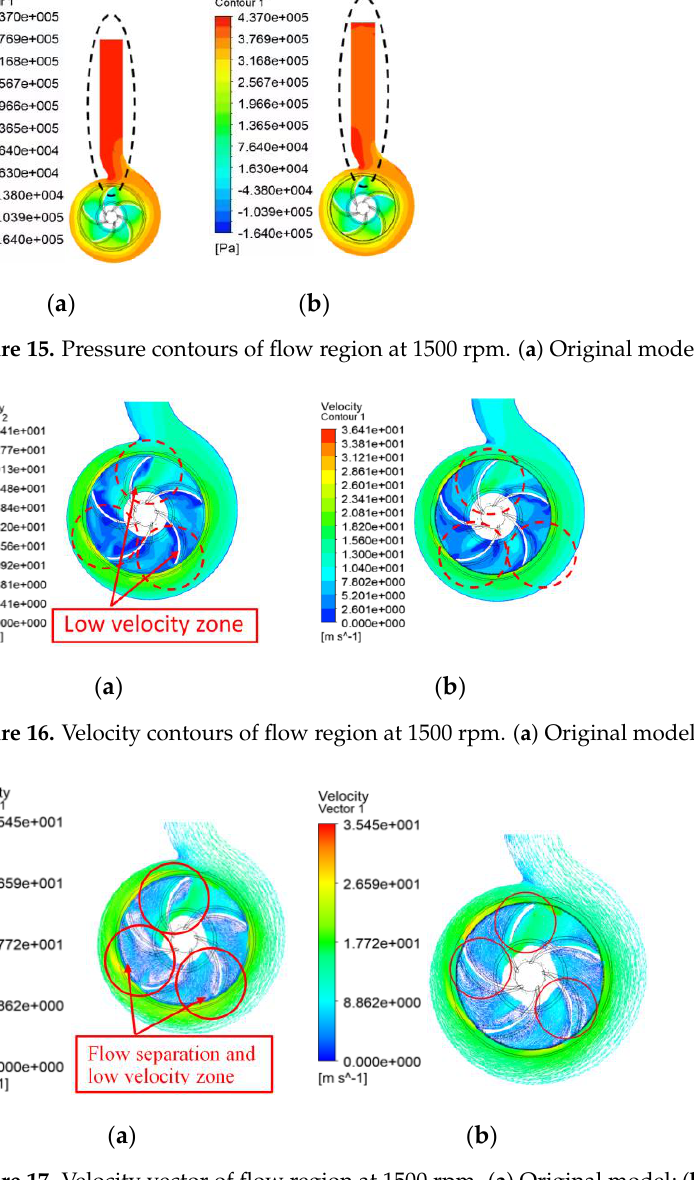
Figure 17. Velocity vector of flow region at 1500 rpm. ( a ) Original model; ( b ) rounded model. Table 6 compares the results of numerical analysis of three different rotating speeds.